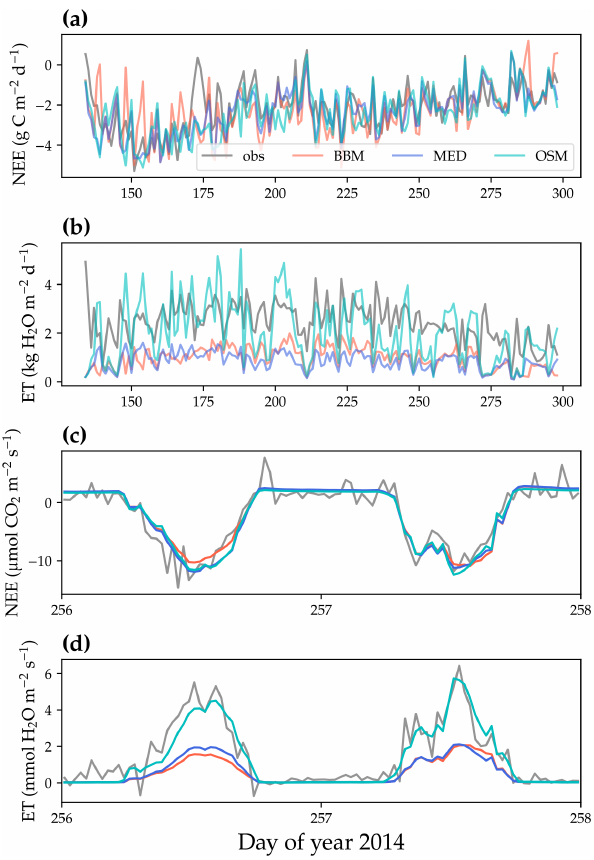
Figure 9. Comparison of model-predicted carbon/water fluxes to the US-MOz (MOFLUX, deciduous angiosperm forest) flux tower – observations for the year 2014. (a) The gray curve plots the daily CO 2 flux in the growing season. The shaded red, blue, and cyan curves plot the respective Ball et al. (1987), Medlyn et al. (2011), and Wang et al. (2020) stomatal model predictions (BBM, MED, and OSM, respectively). (b) Comparison of modeled and observed daily total transpiration flux. (c) Comparison of half-hourly mod- eled and observed net ecosystem carbon flux (NEE) for days 256– 257 of the year 2014. (d) Comparison of modeled and observed ecosystem water flux (ET) for days 256–257 of the year